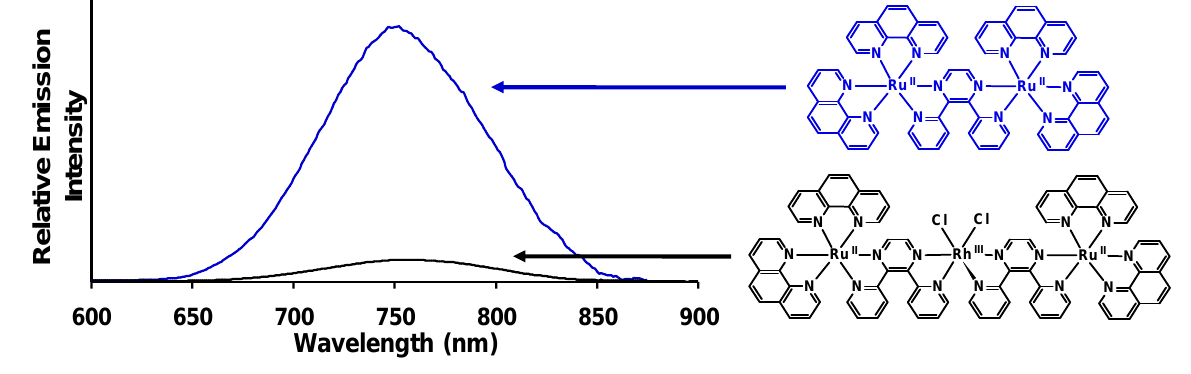
Figure 14. Emission spectra of the trimetallic complex [{(phen) and the corresponding [(phen) acetonitrile (phen = 1,10-phenanthroline, dpp = 2,3-bis(2-pyridyl)pyrazine). Emission spectra are corrected for PMT